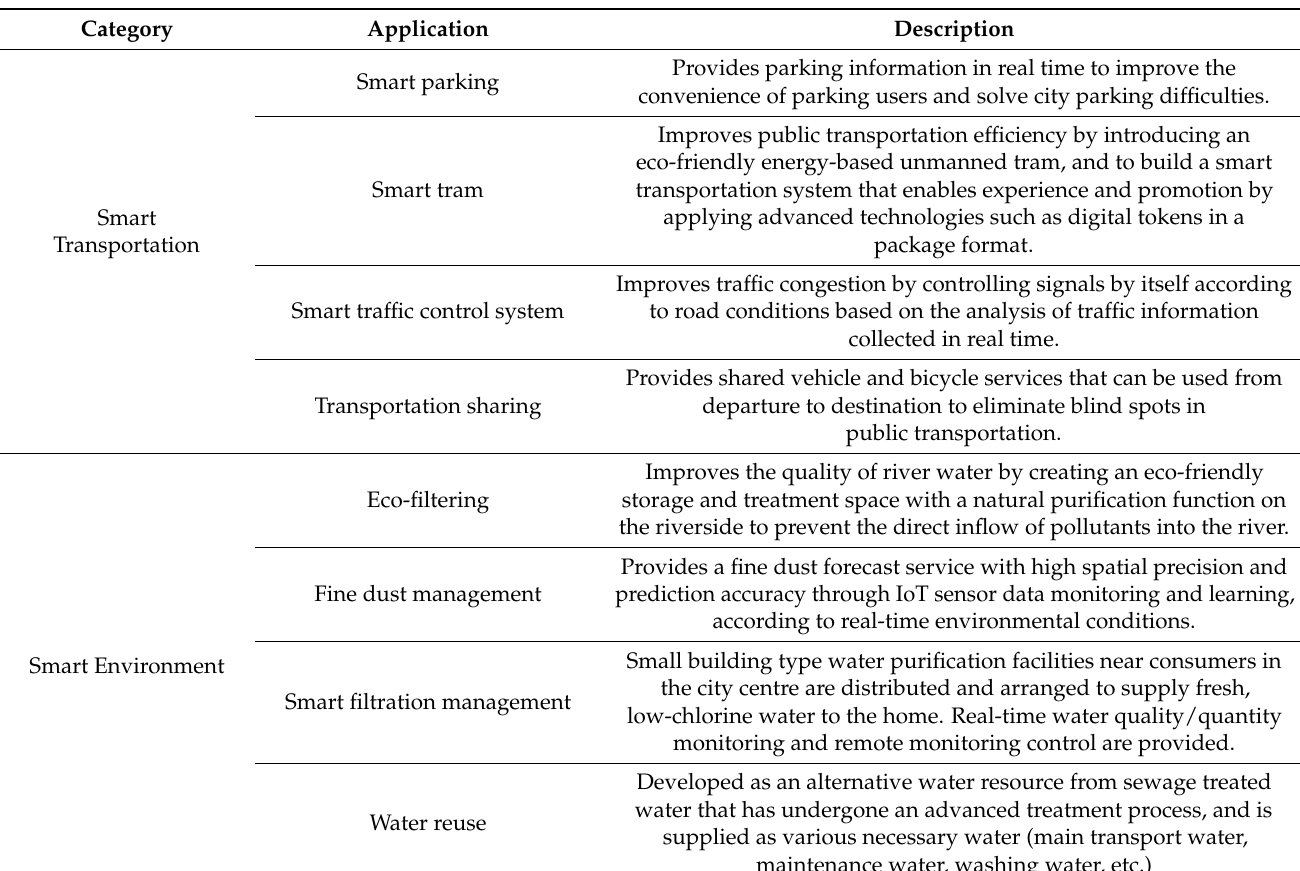
Table 3. Smart city applications